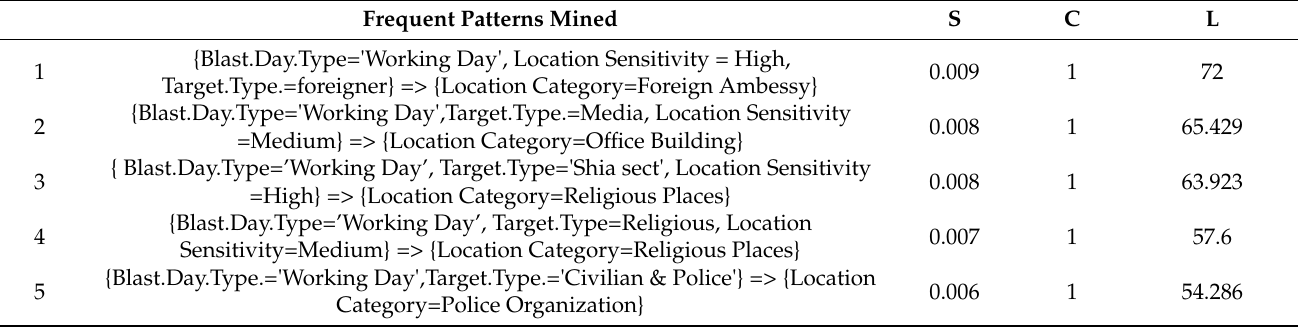
Table 6. Sample strong and interesting frequent patterns mined from the suicide bombing attack